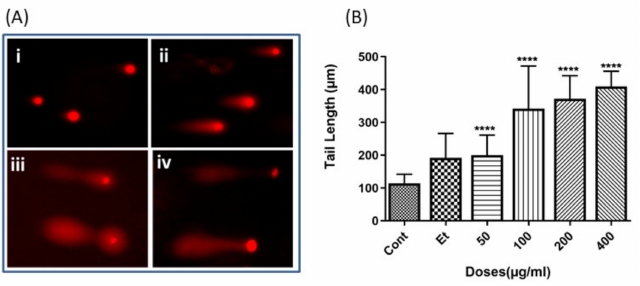
Figure 2. Leaf crude extract of OI triggers gDNA fragmentation in PC3 cells: PC3 cells were treated with 50, 100, 200 or 400 µ g/mL of leaf crude extract dissolved in PBS. The negative control cells (Cont) were treated with PBS. After treatment ( A ), comet assays were conducted as described in the Materials and Methods: (i) control, (ii) 50 µ g/mL, (iii) 200 µ g/mL, (iv) and 400 µ g/mL. ( B ) The tail length of 25 comets in each group was measured, and the mean and standard deviation were calculated. p -values were calculated for each group, comparing with the control group using Student’s “ t ” test. **** indicates p -values > 0.0001. The bars indicate SD.